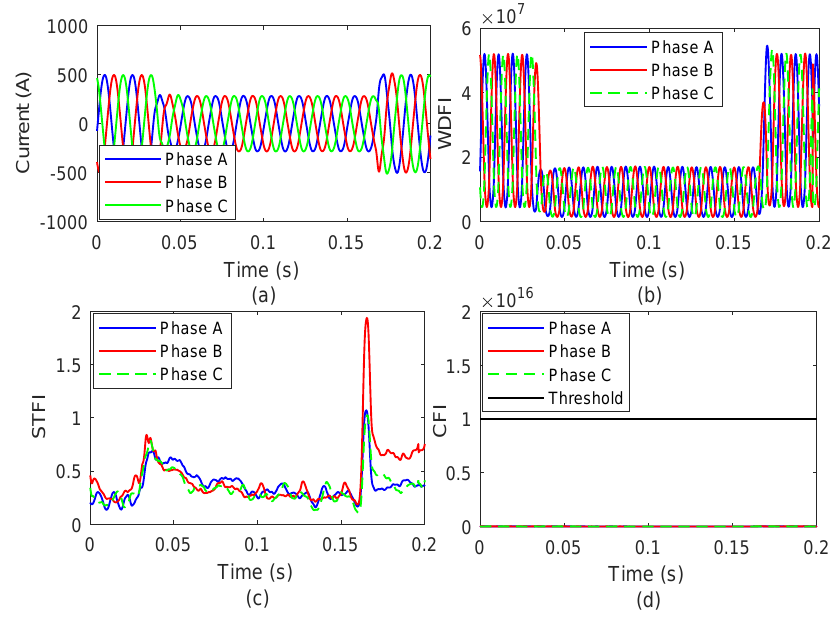
Figure 16. Event of load switching ( a ) current waveform ( b ) WDFI ( c ) STFI ( d )